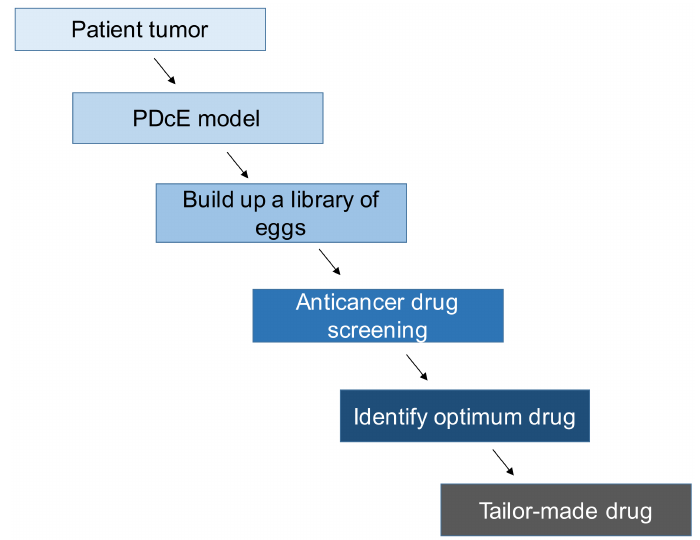
Figure 3. A scheme for the use of PDcE model to develop tailor-made drug for an individual